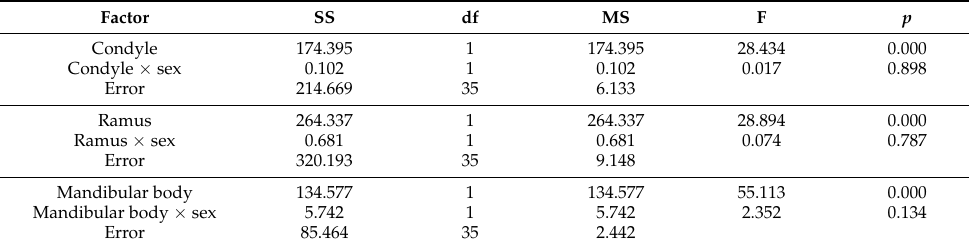
Table 3. Repeated-measures analysis of variance for adjustment of sex for line measurements.